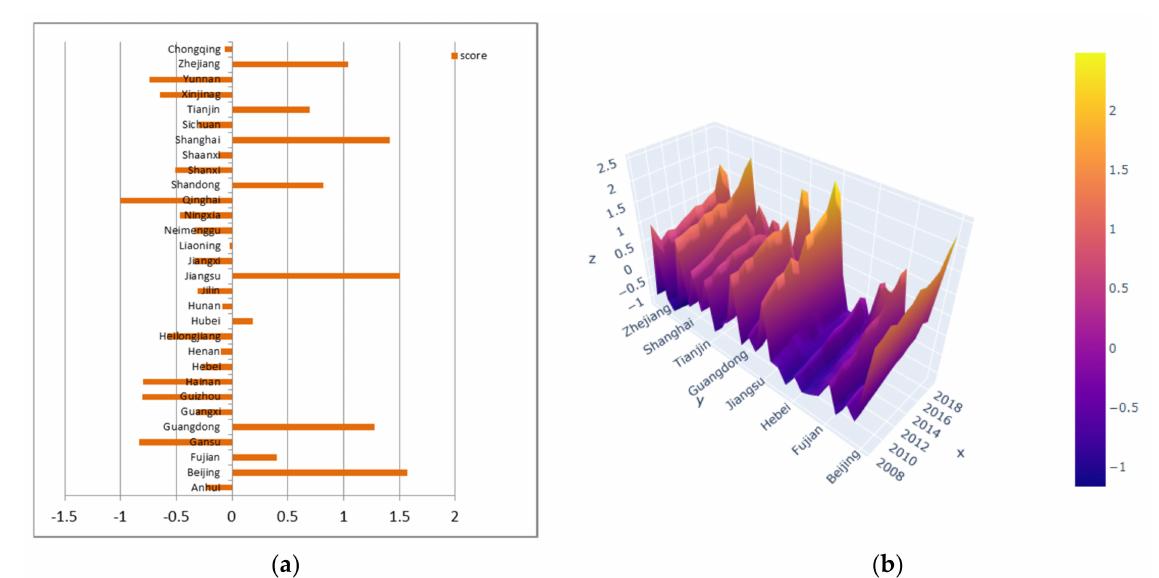
Figure 2. The green upgrade efficiency of each province in China from 2008 to 2018 ( a ) and its distribution in the major regions from 2008 to 2018 ( b